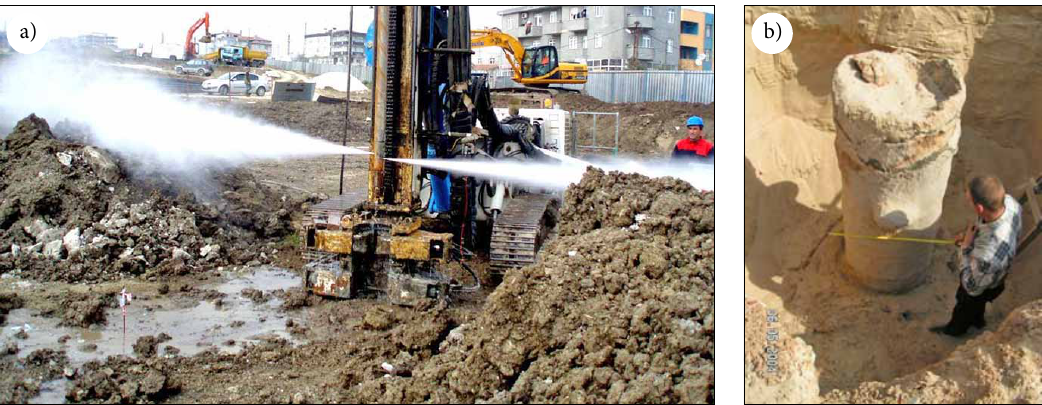
Fig. 1. Specificities of jet grouting technology: a – in the course of jet grouting, cement slurry is injected into soil through small- diameter nozzles (Jet grouting... 2016), b – cement slurry is mixed with soil, and cement treated grout columns are received